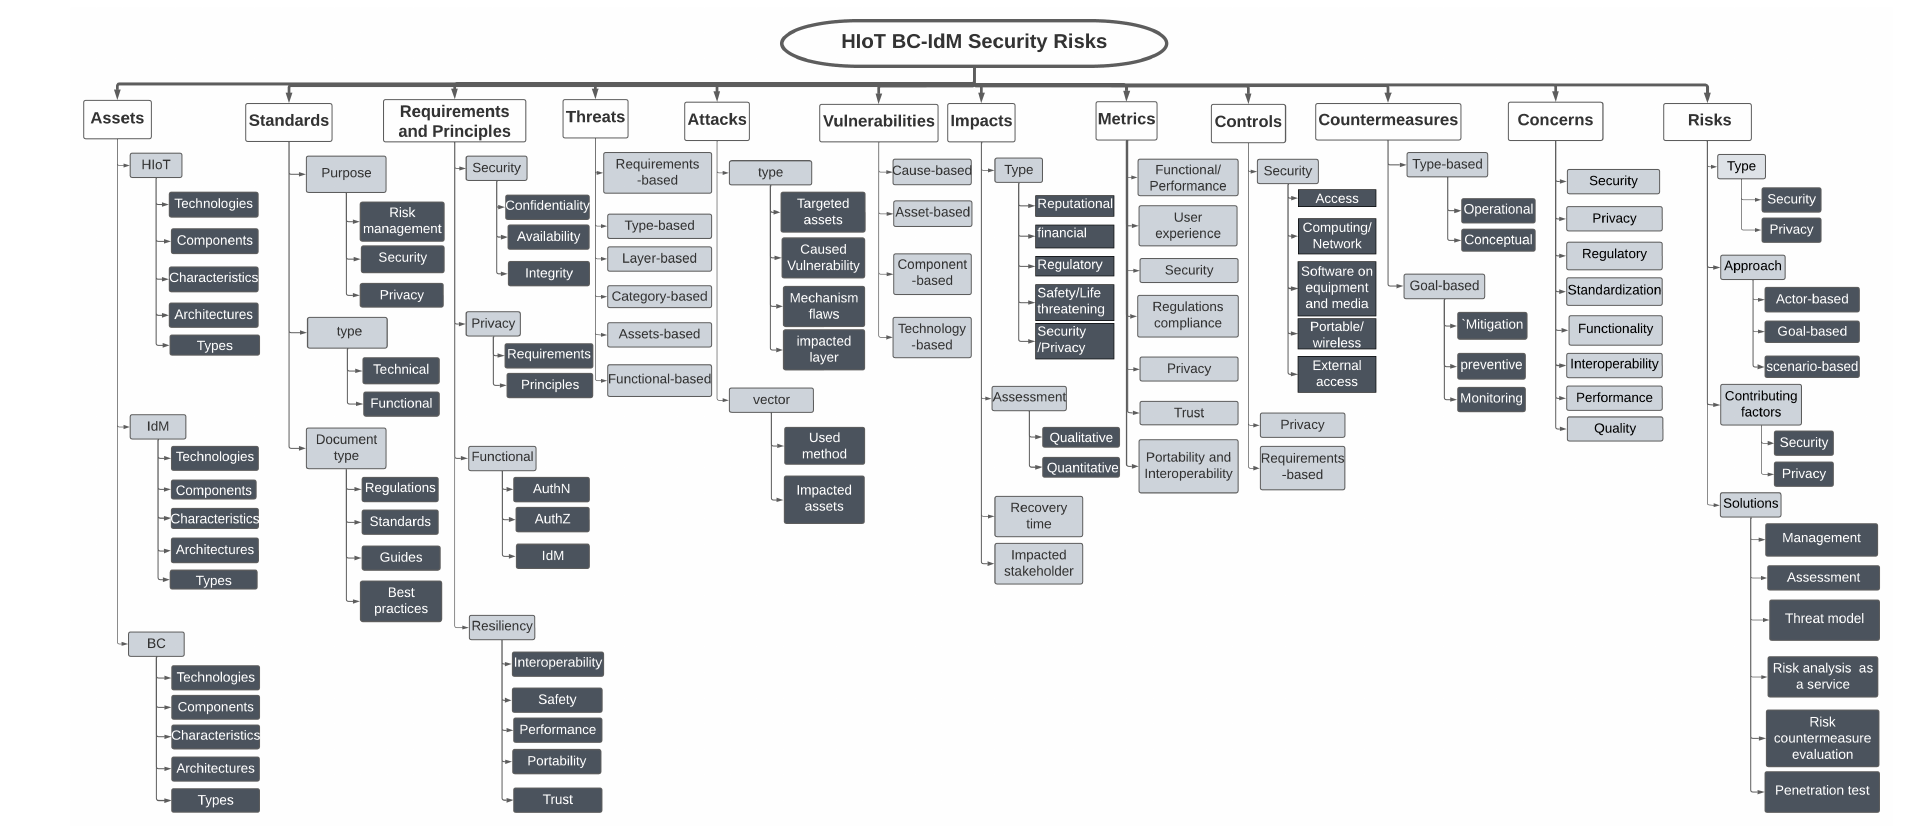
Figure 4. The security risk taxonomy for HIoT BC-IdM